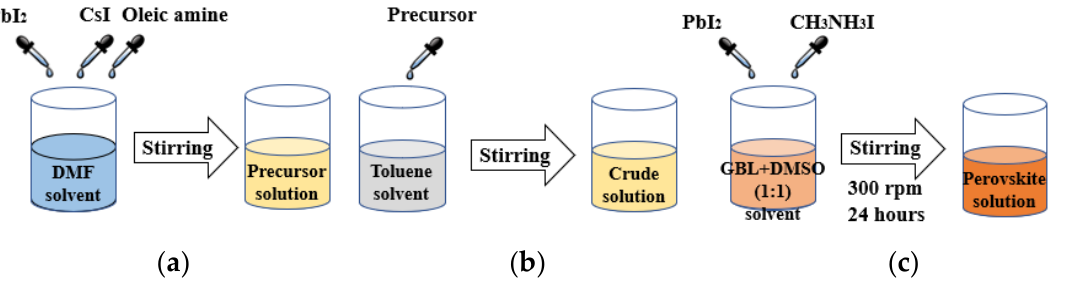
Figure 1. Schematic diagram of the PQD preparation for ( a ) the precursor solution to obtain ( b ) the crude quantum dots (QDs) solution via the ligand-assisted reprecipitation method (LARP) and ( c ) the MAPbI 3 solution to be obtained.